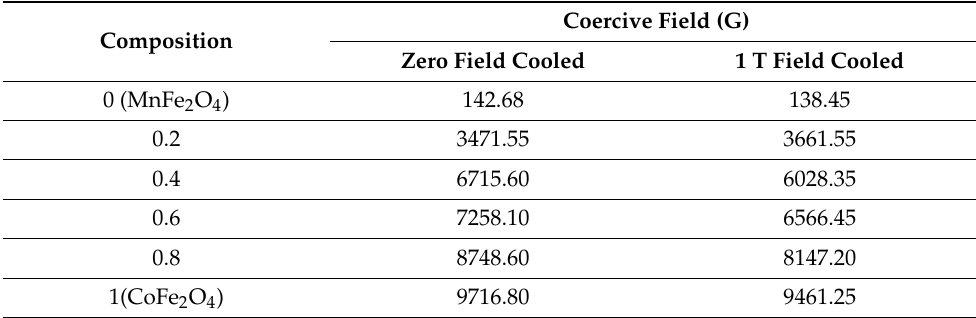
Table 4. The Coercive field values of the nanoparticles obtained with zero and 1 T field cooled conditions at 5 K